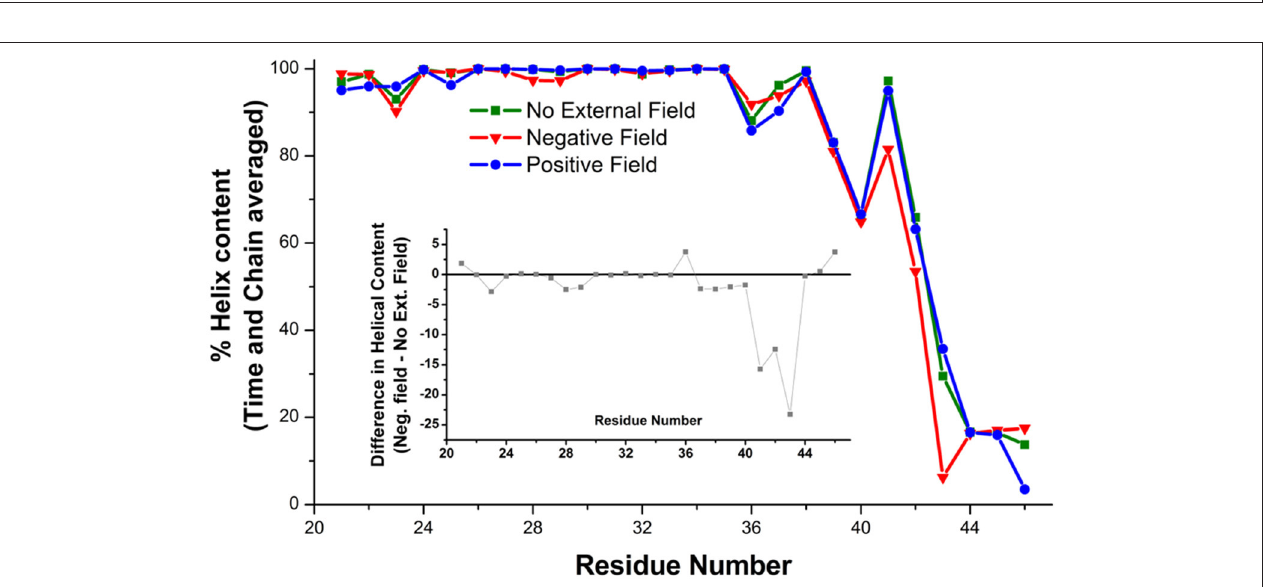
FIGURE 6 | Helical content on the amino acids of the TM1 averaged on six Connexin chains and over the last µ s of the simulation. The inset shows the difference between the simulations in absence (green squares) and presence (red triangles) of a hyperpolarizing electric field.